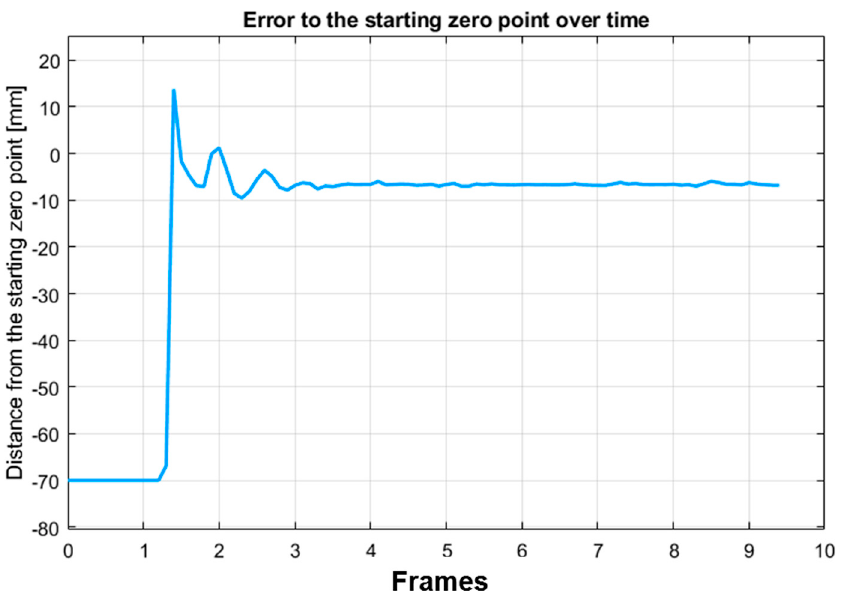
Figure 15. Error to the starting zero point with a 0.08 gain value.